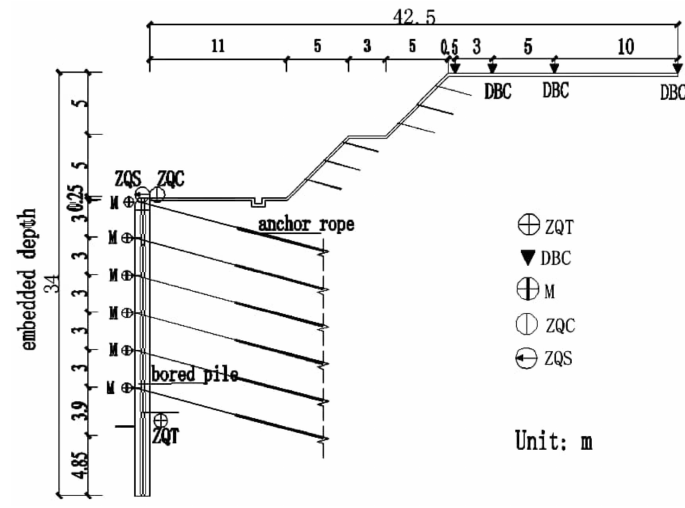
Figure 4. Layout of monitoring cross-section.